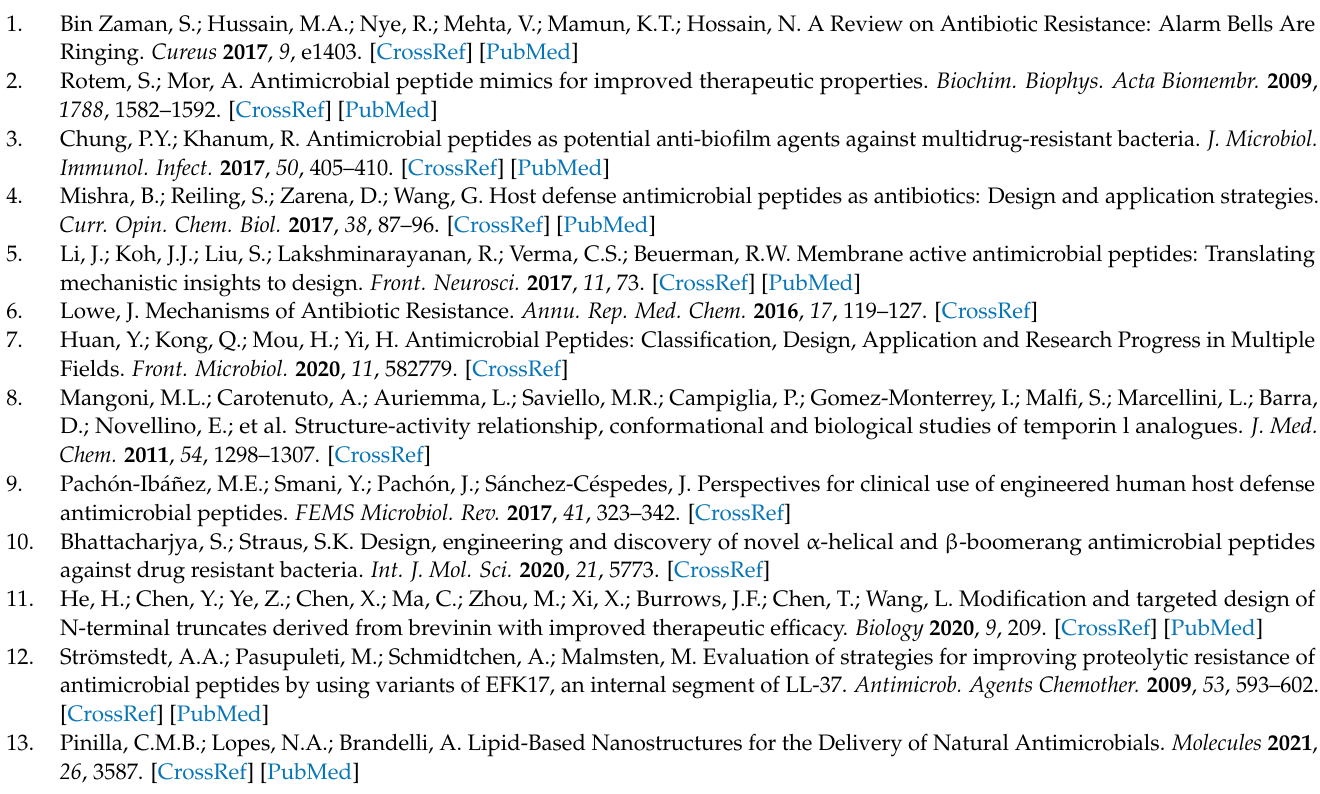
Table S2: Two-way ANOVA analysis of permeability of Temporin-1CEh and its analogues against E. coli . The significance was presented by the symbol ns (non-significant difference), * ( p < 0.05), ** ( p < 0.01), *** ( p < 0.001) and **** ( p <